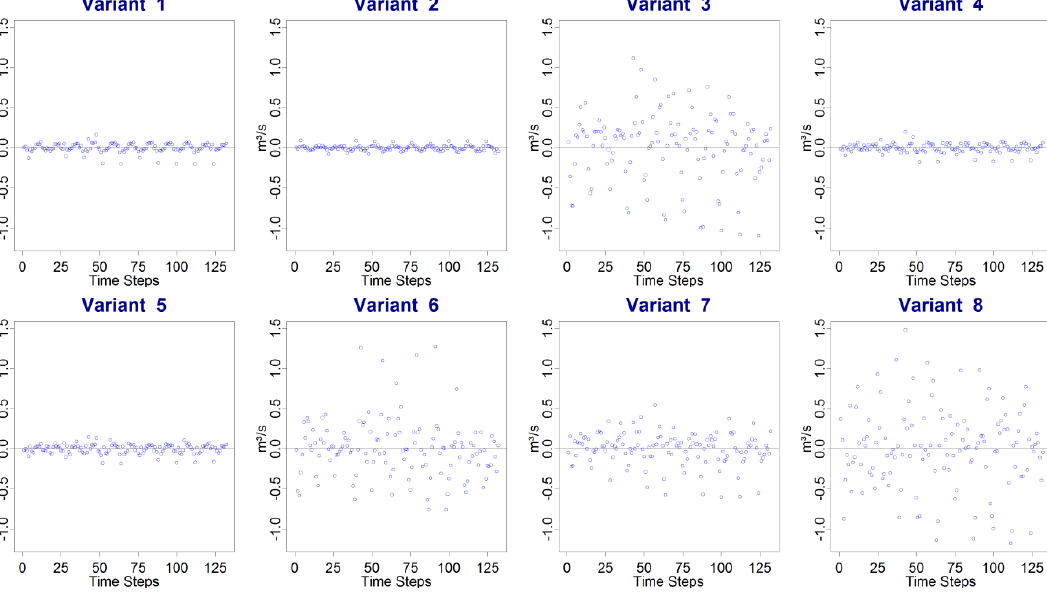
Figure 9. Residuals of the monthly discharge values downstream of the wetland (variants 1 to 8 compared to variant 0).